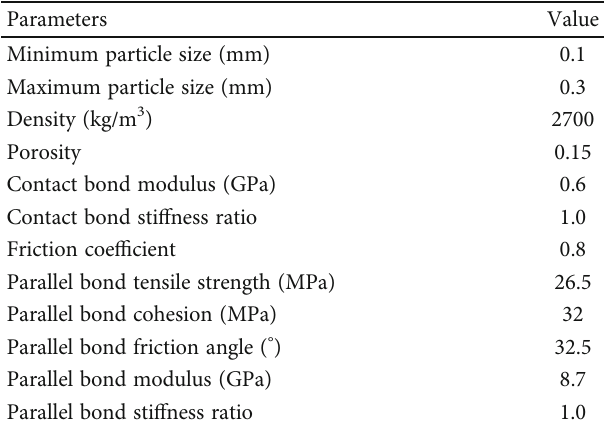
Table 1: Mesoscopic parameters of the PFC 2D medium.